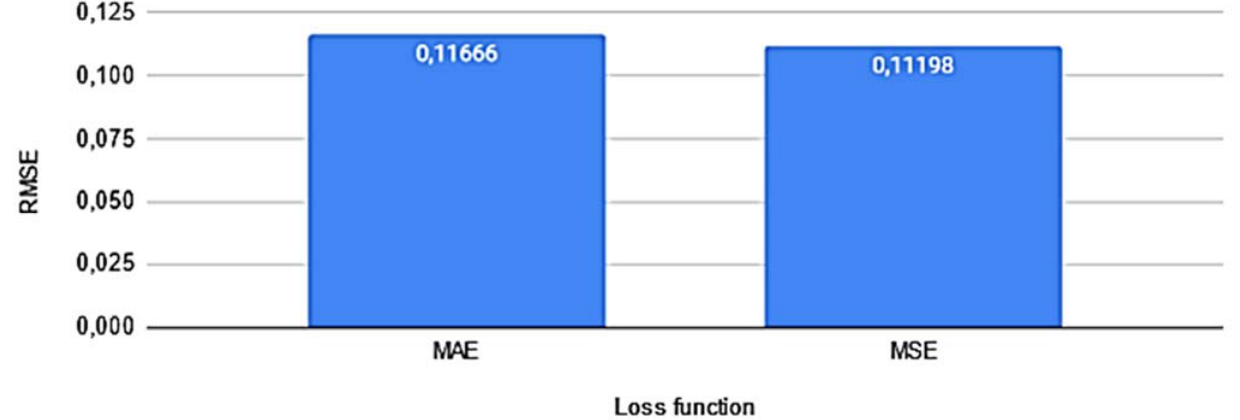
Figure 10. Average RMSE concerning loss function for the validation set on 2 h prediction horizon and 128 neurons per layer.